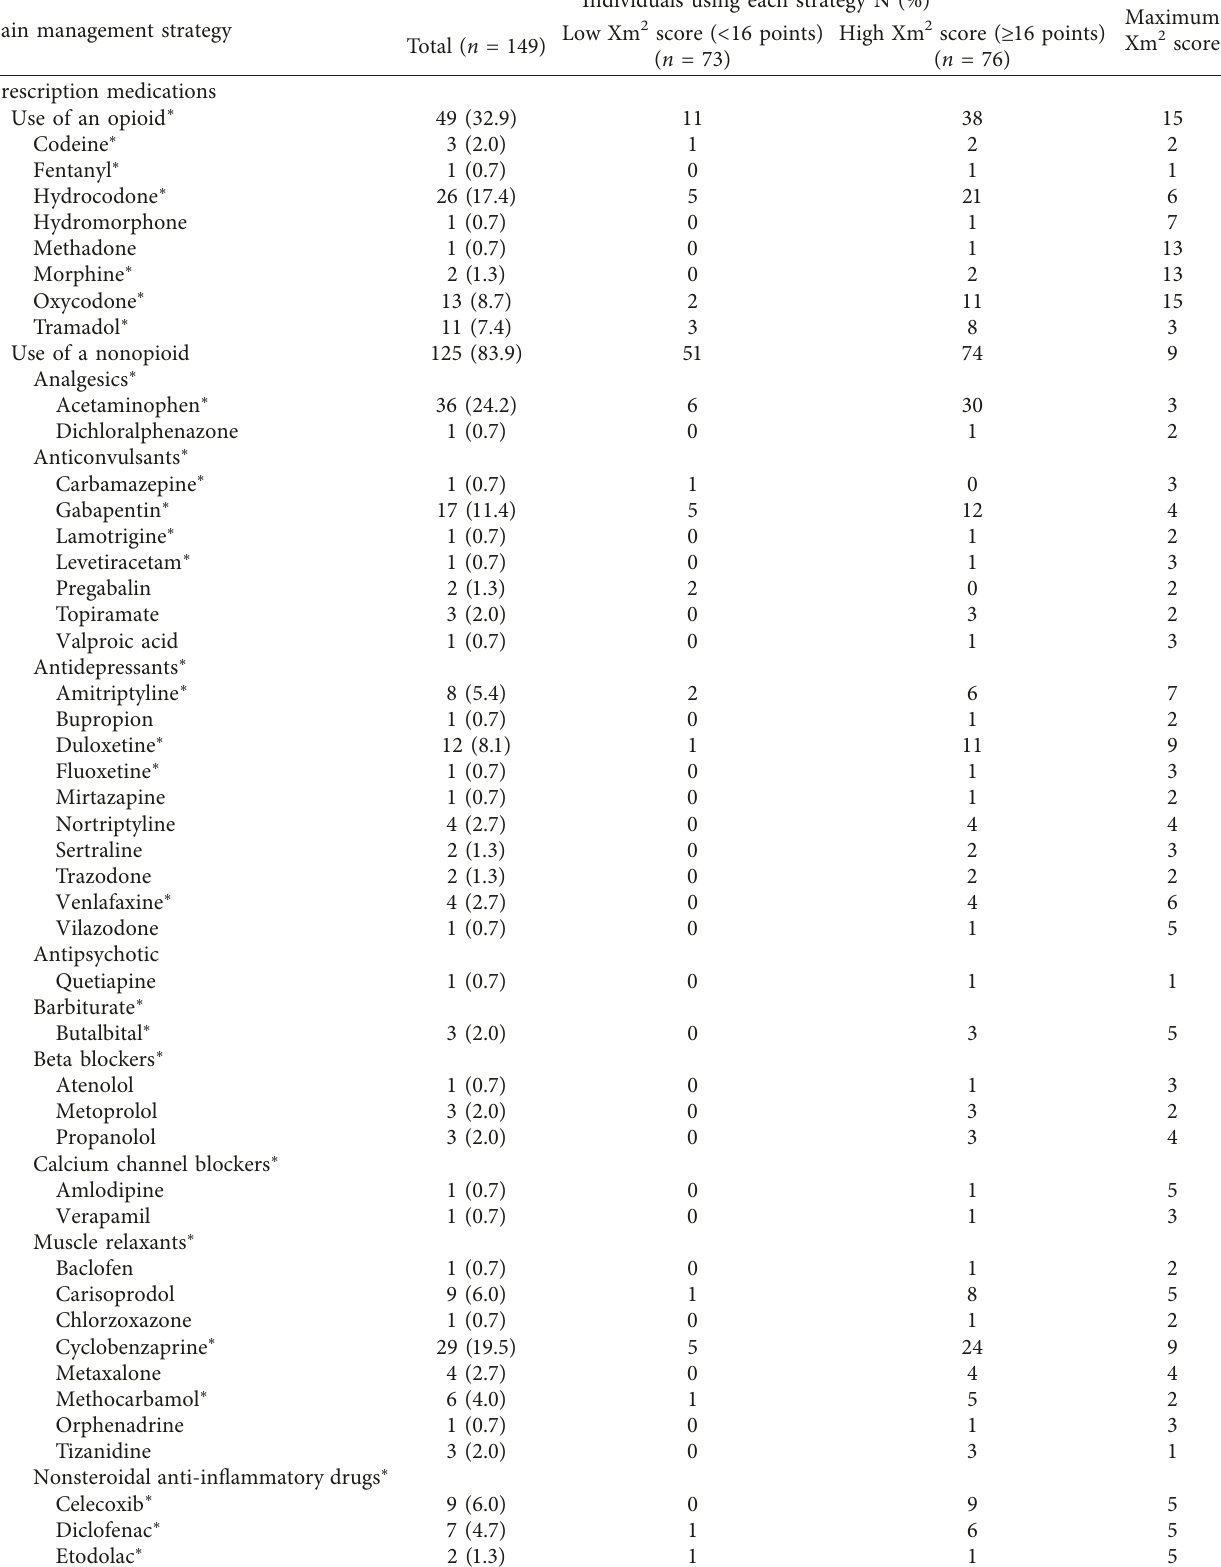
Table 2: Number of individuals using each pain management strategy identified in the study organized by low or high Xm 2 score and maximum Xm 2 score for each